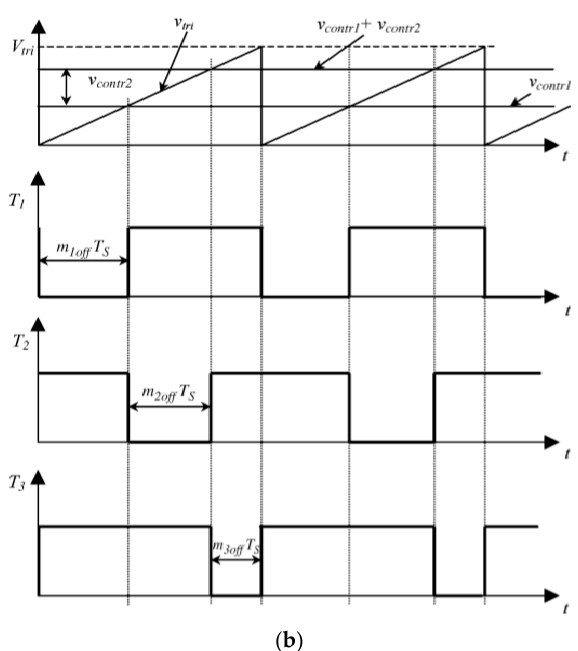
Figure 3. ( a ) Firing pulse generation logic. ( b ) Firing pulse generation signals.